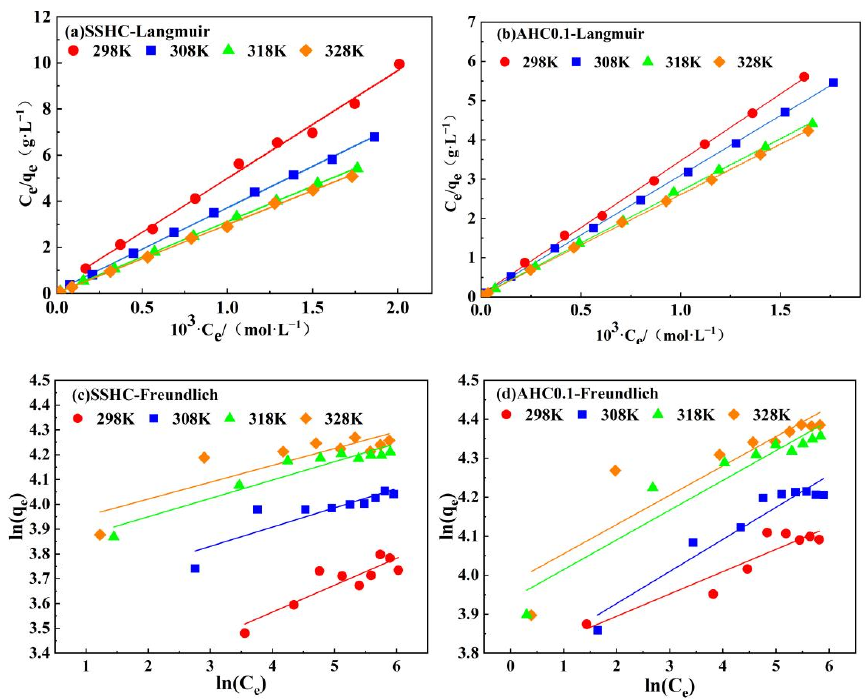
Figure 10. Linear fitting of experimental data using Langmuir model and Freundlich model.